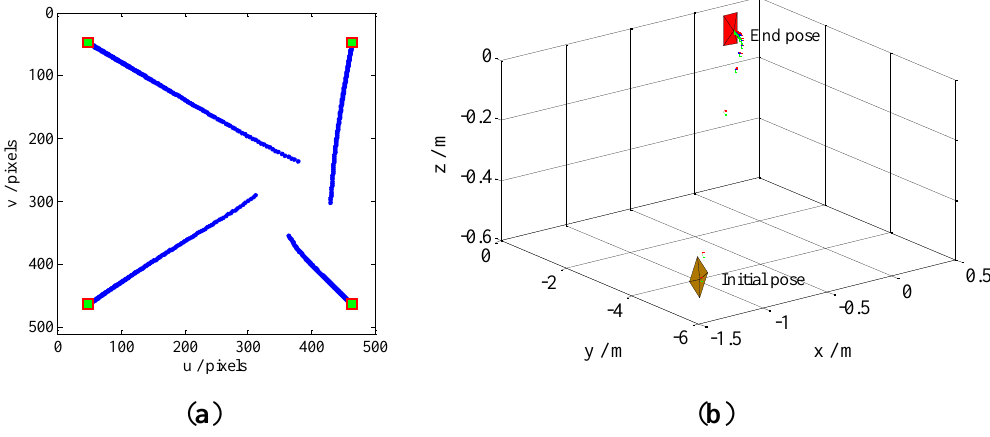
Figure 7. Results obtained by the IBVS method for Case 1. The camera parameters are the same as in the PBVS method. The feature trajectories are constrained on the FOV, but the camera trajectory becomes slightly odd, i.e. , the camera moves abruptly. ( a ) The feature trajectories; ( b ) The camera trajectory.